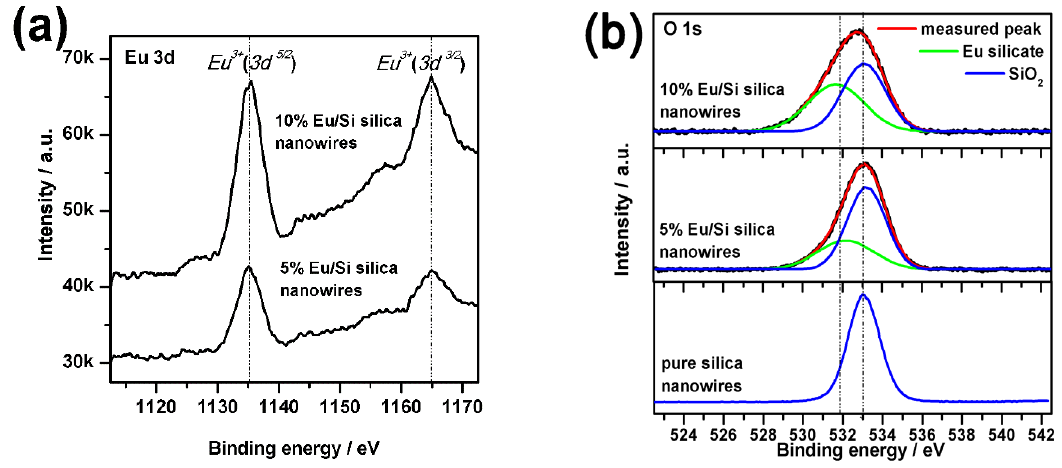
Figure 6. XPS spectra of ( a ) Eu 3d and ( b ) O 1s for Eu 3+ -doped SiO 2 nanowires in different doping content after calcination.